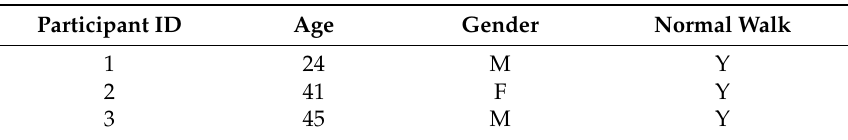
Table 1. Participant